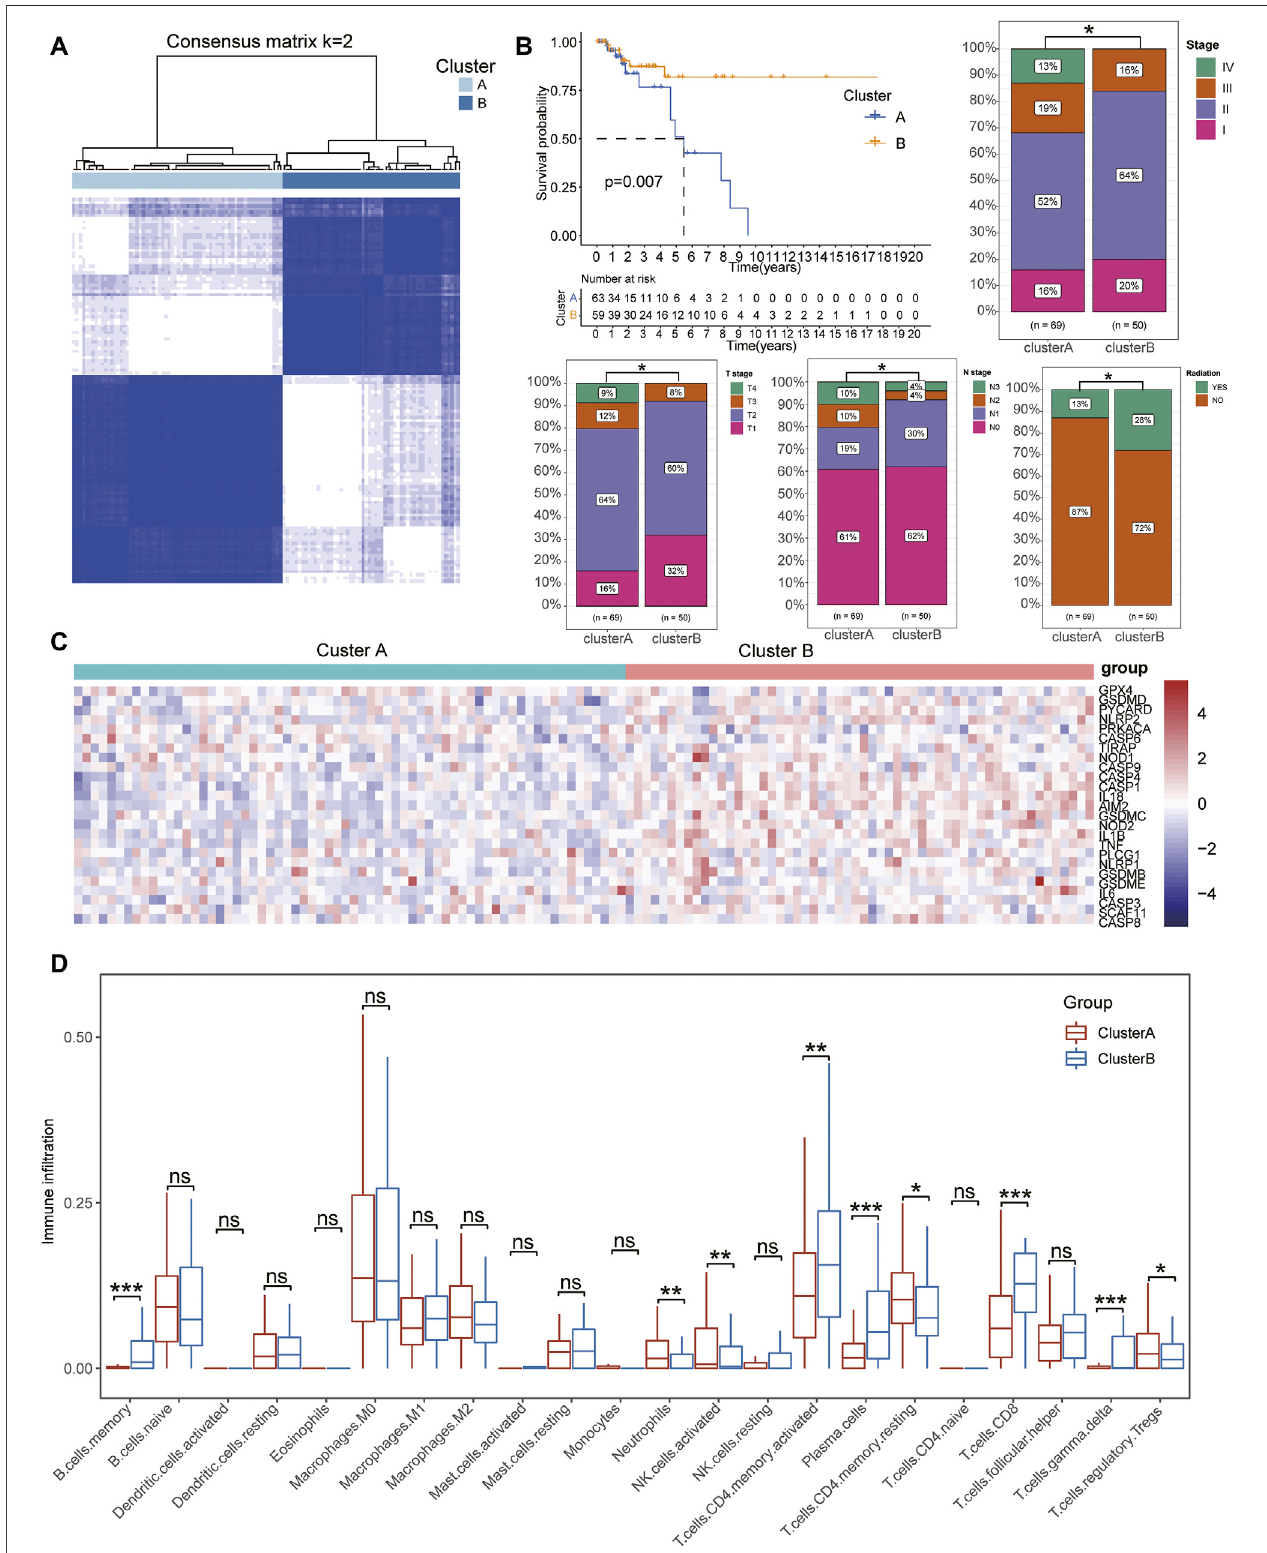
FIGURE2| Identi fi cationofpyroptosis-relatedsubtypesinTNBC. (A) Consensusclusteringmatrixfor k =2inpatientswithTNBC. (B) Kaplan – MeiercurvesofOSforpatientswith